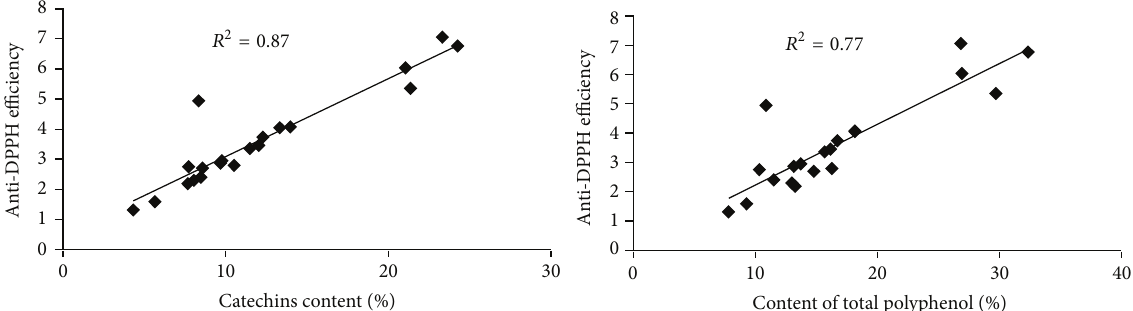
Figure 7: Correlation analysis of anti-DPPH efficiency (AE) values versus total polyphenols and catechins in tea.